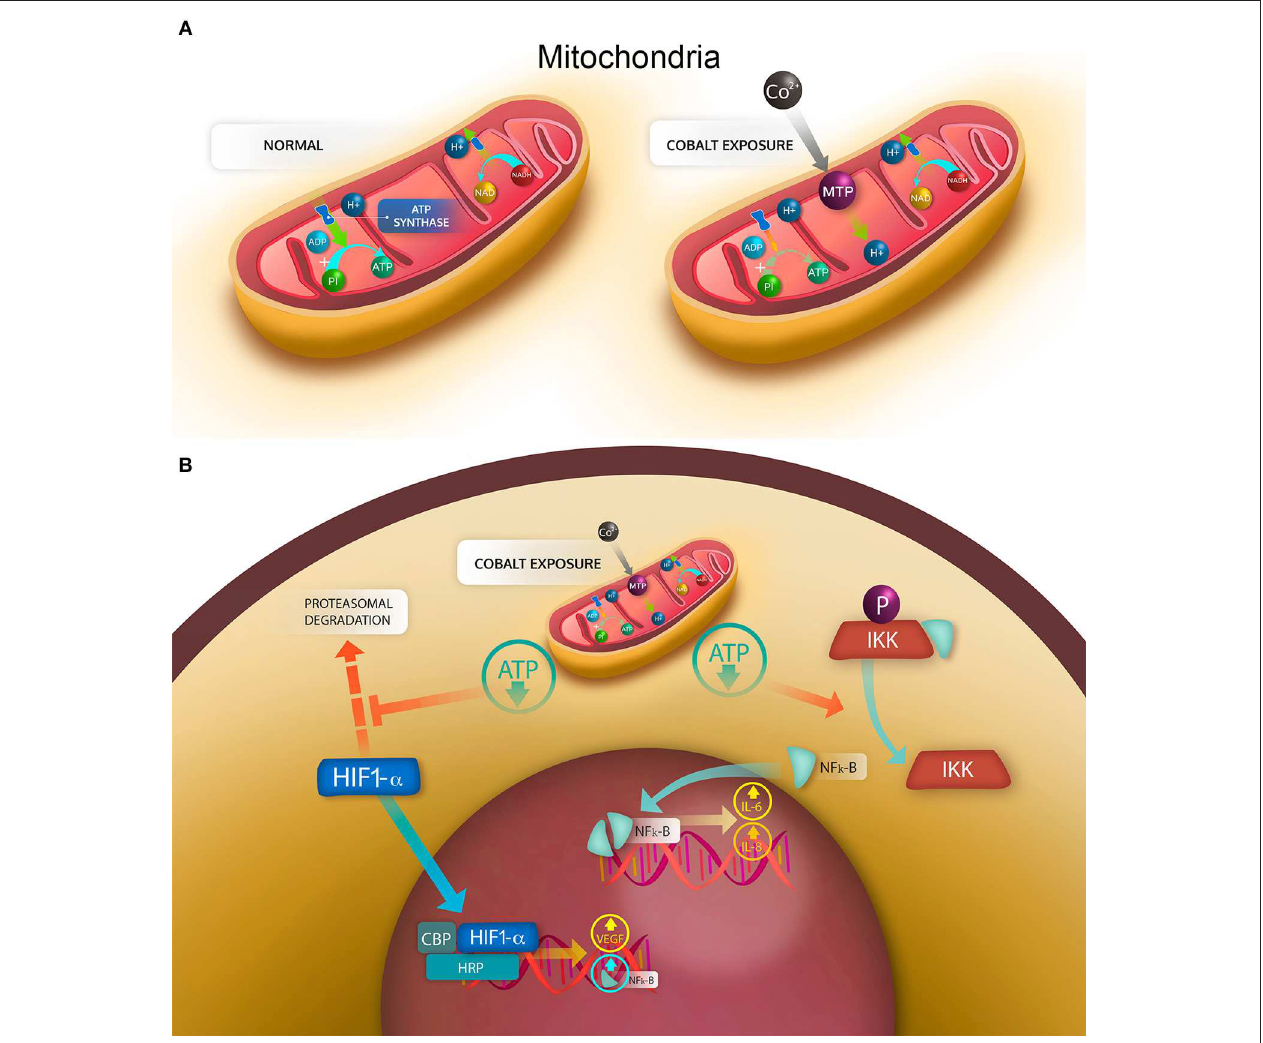
FIGURE 8 | Mechanisms of cell damage induced by cobalt ions. (A) mitochondrial stress generated by the cobalt-induced opening of the mitochondrial transition pore (MTP). Under normal conditions in aerobic respiration, the H + generated during the tricarboxylic acid cycle in the form of NADH and NAPH are transferred to the intermembrane space by the electron transport chain, generating an electrochemical gradient, in which a high concentration of H + is found in the intermembrane space. By use of this electrochemical gradient, the ATP synthase can phosphorylate ADP into ATP. With the opening of MTP, the electrochemical gradient is lost, then the synthesis of ATP is decreased. (B) cellular effects of the mitochondrial stress. Under normal conditions, the hypoxia induced factor HIF-1 α is degraded by the proteasome; similarly, phosphorylated IKK bound in the cytoplasm NF- κ B. With a drop in ATP, the degradation of HIF-1 α is decreased, allowing HIF-1 α to translocate into the nucleus and bind CBP and HRP to enhance transcription of target genes, such as NF- κ B and VEGF. The decrease in ATP also reverses the phosphorylation of IKK that in a non-phosphorylated state releases NF- κ B, which dimerizes and translocates to the nucleus, binding DNA and enhancing the transcription of target genes, such as IL-6 and